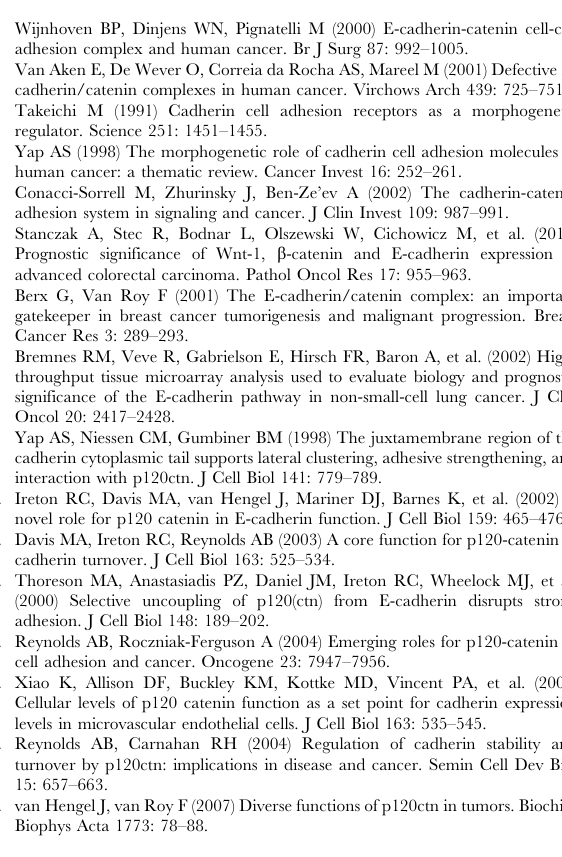
Figure S2 Effects of p120ctn isoforms on E-cadherin expression and cell invasiveness in LTE cell line. (A) Effect on E-cadherin expression by immunofluorescence staining.